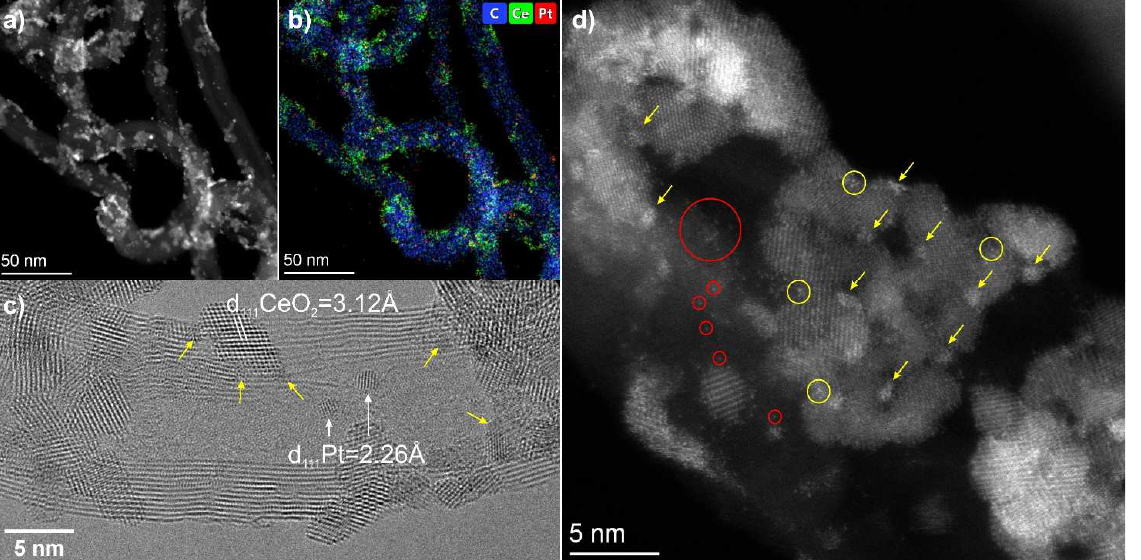
Figure 3. TEM data for Pt-Ce-C catalyst: ( a , b ) HAADF-STEM image and corresponding EDX-mapping patterns showing distribution of C (blue), Pt (red) and Ce (green); ( c ) HRTEM image; ( d ) HAADF-STEM image. The yellow arrows in images indicate the location of Pt sub-nanometer clusters on the ceria surface; the red circles mark the location of single atoms (Pt and Ce) and grouped single atoms on the MWCNT surface; the yellow circles indicate individual and grouped single Pt atoms on the ceria surface.